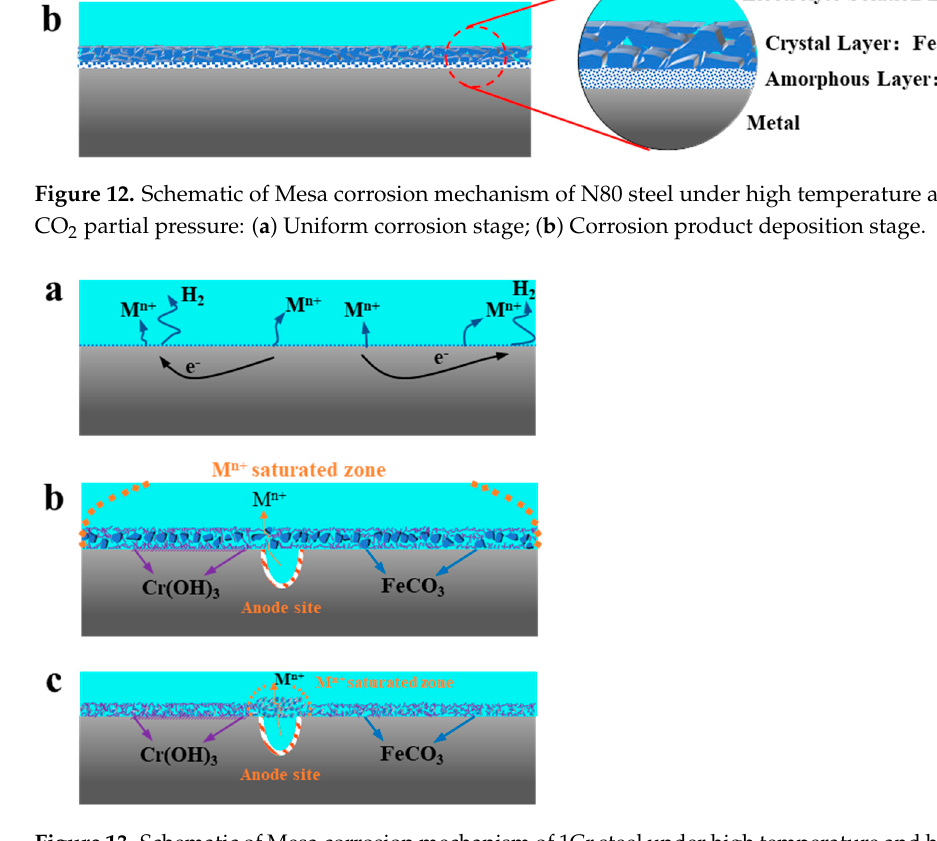
Figure 13. Schematic of Mesa corrosion mechanism of 1Cr steel under high temperature and high CO 2 partial pressure: ( a ) Uniform corrosion stage; ( b ) The competitive deposition of corrosion products and pitting incubation stage; ( c ) Pitting corrosion development and formation stage.